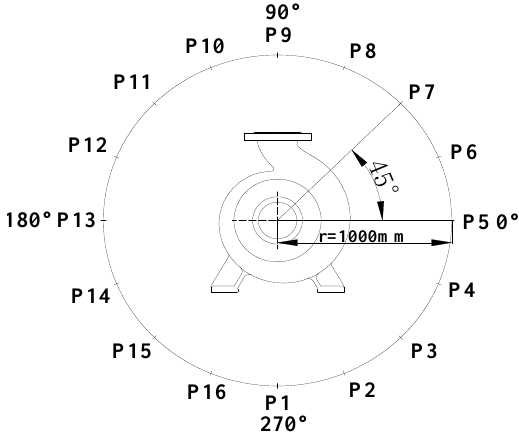
Figure 2. Arrangement of monitoring points in a circumferential direction.